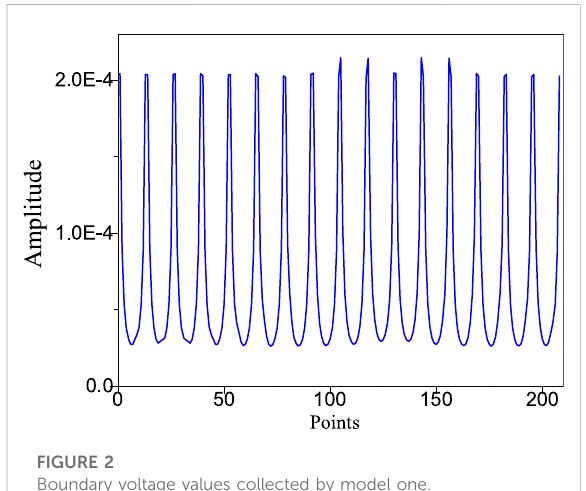
FIGURE 2 Boundary voltage values collected by model